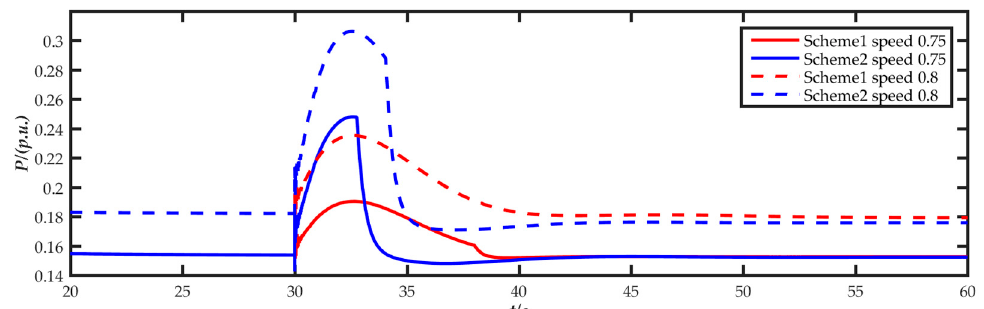
Figure 10. Power change in wind turbines in the low-wind speed zone.